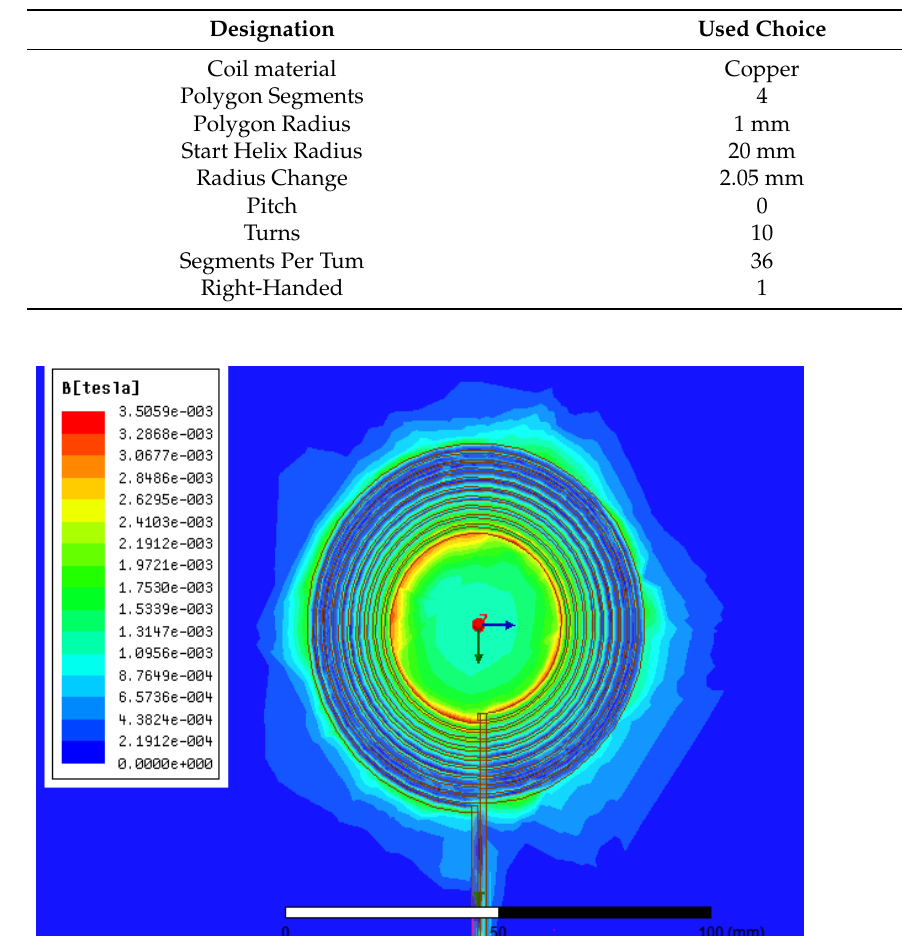
Figure 6. Distribution of magnetic flux density in the coil using Ansys Maxwell software.